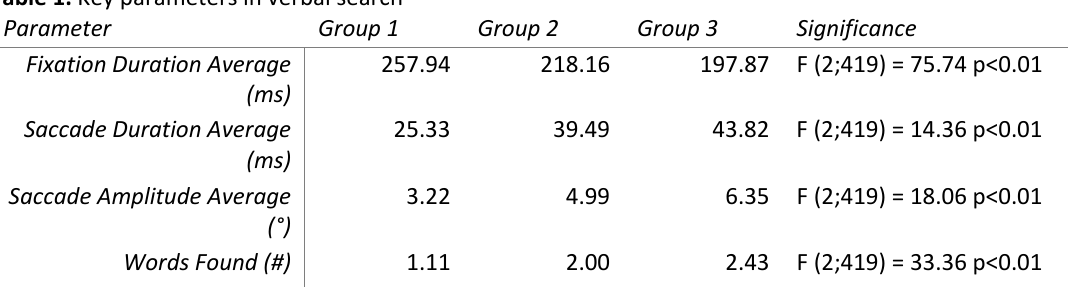
Table 1. Key parameters in verbal